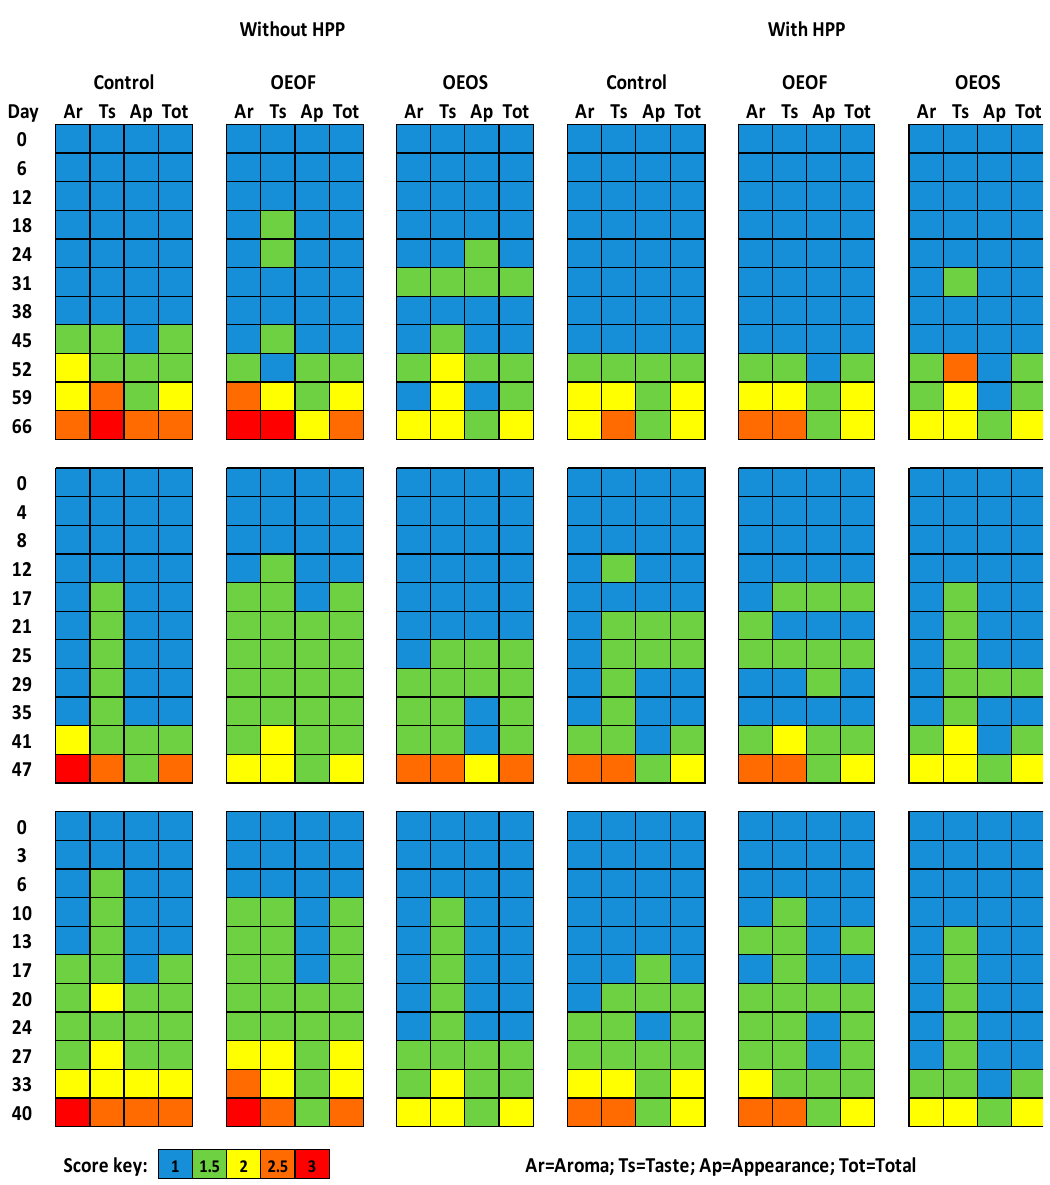
Figure 7. Sensory scores for ham slices without and after the high pressure processing treatment, during storage at 4 (upper line), 8 (middle line) and 12 ◦ C (bottom line). The “total” value represents the mean value of aroma, taste and appearance of each sample rounded to the closest value. Scores regarding control and OEOF samples (without essential oil), are common with those reported in our previous study [52].